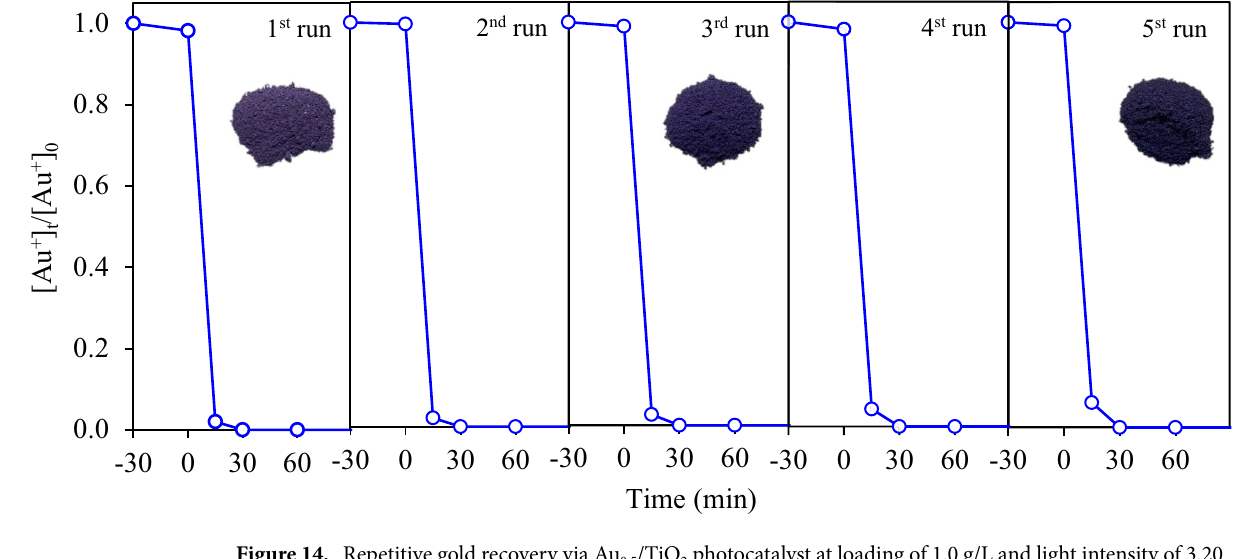
Figure 14. Repetitive gold recovery via Au 0.5 /TiO 2 photocatalyst at loading of 1.0 g/L and light intensity of 3.20 mW/cm 2 in the presence of 20 vol% CH 3 OH as the hole scavenger.